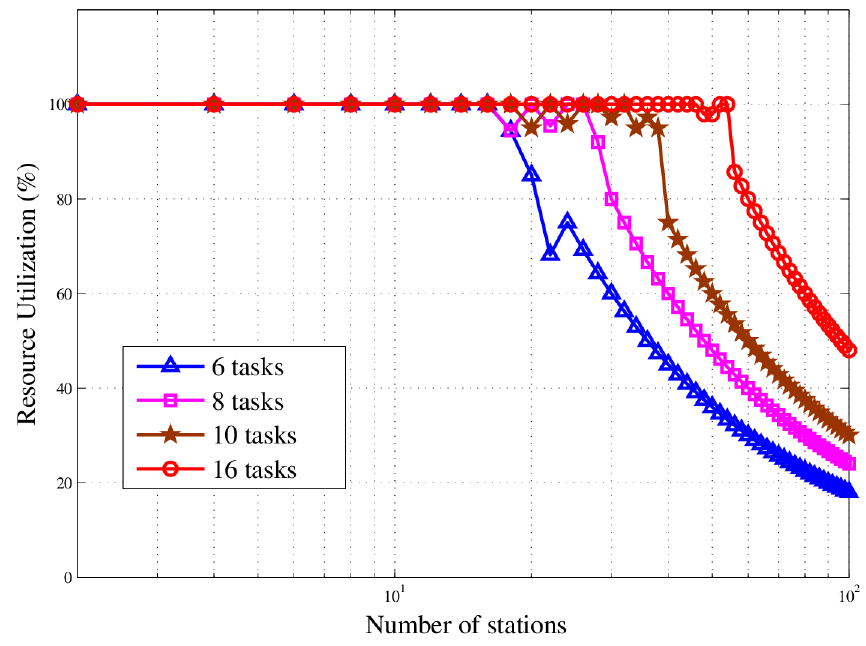
Figure 22. Resource utilization curve in different scenarios.